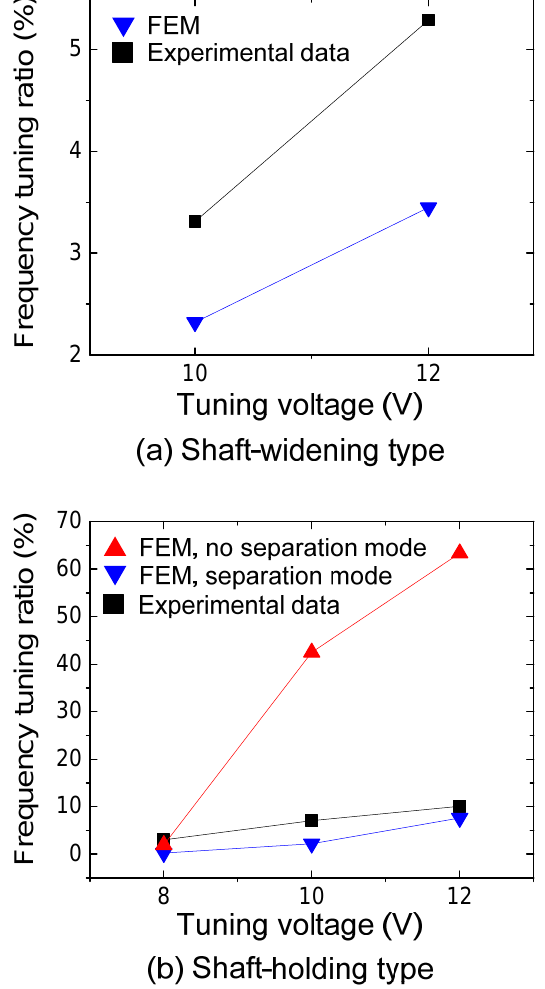
Figure 11. Measured and simulated results for resonant frequency change as a function of applied tuning voltage: ( a ) The shaft ‐ widening type; ( b ) the shaft ‐ holding type.